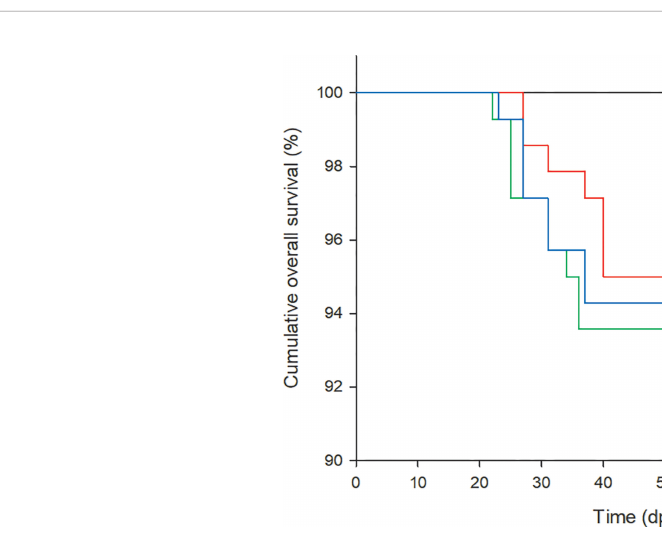
FIGURE 7 | Cumulative overall survival rate of tilapia in Experiment